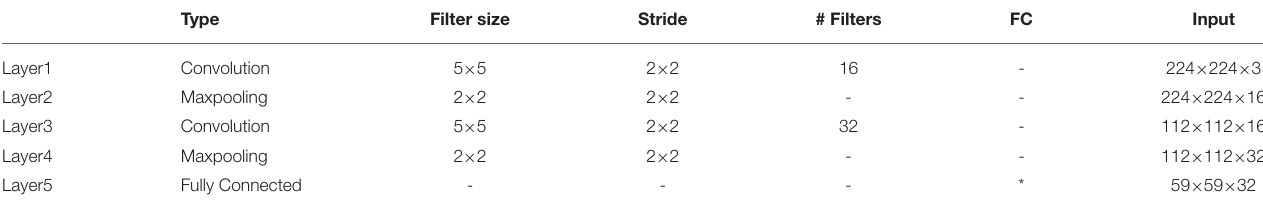
TABLE 1 | A display of the parameters used in the CNN network.